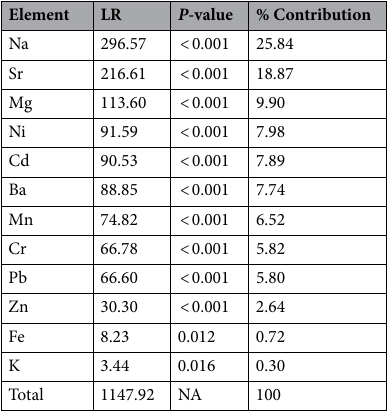
Table 1. Univariate GLM results for the otolith chemistry analysis. For each element, the Likelihood Ratio test statistic (LR; 2 dp) and P -value (3 dp) are shown as well as the % contribution to the multivariate differences (2